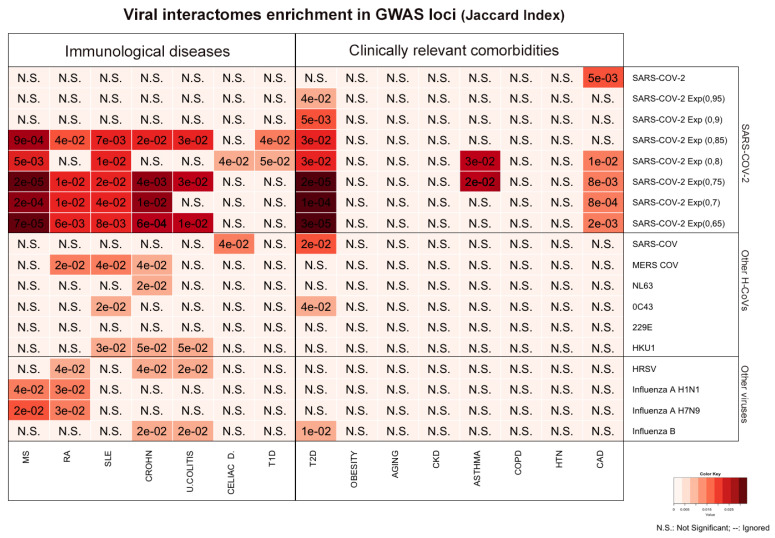
Viral interactomes enrichment in GWAS loci.The heatmap shows the Jaccard Index of the overlaps of gene sets associated with immunological diseases and COVID-19 relevant comorbidities with viral interactomes. SARS-CoV-2 section shows in the first line the host protein network derived from experimental evidence
9, followed by results obtained overlapping the expanded networks generated with HIPPIE settings at different confidence levels (0,95 to 0,65). HRSV: Human Respiratory Syncitial Virus; MS: Multiple Sclerosis; RA: Rheumatoid Arthritis; SLE: Systemic Lupus Erythematosus; CROHN: Crohn’s Disease. U.COLITIS: Ulcerative Colitis; CELIAC D.: Celiac Disease; T1D: Type 1 Diabetes Mellitus; T2D: Type 2 Diabetes Mellitus; CKD: Chronic Kidney Disease; COPD: Chronic Obstructive Pulmonary Disease; HTN: Hypertension; CAD: Coronary Artery Disease.